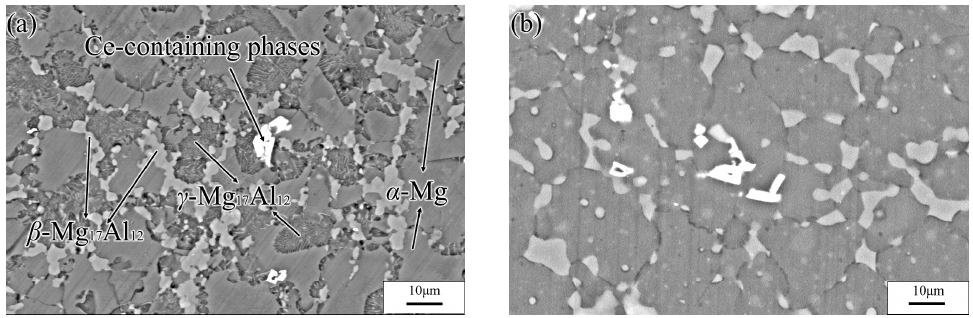
Figure 2. SEM images of Mg-16Al Mg alloy before ( a ) and after ( b ) solution treatment with 400 °C holding for 12 h.